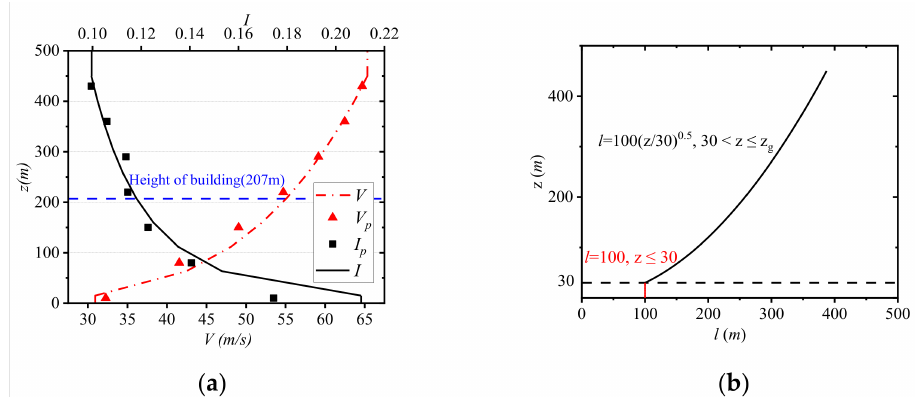
Figure 2. Numerical simulation of wind field characteristics at the entrance. ( a ) Velocity and turbulence profiles; ( b ) Turbulence integration scales.